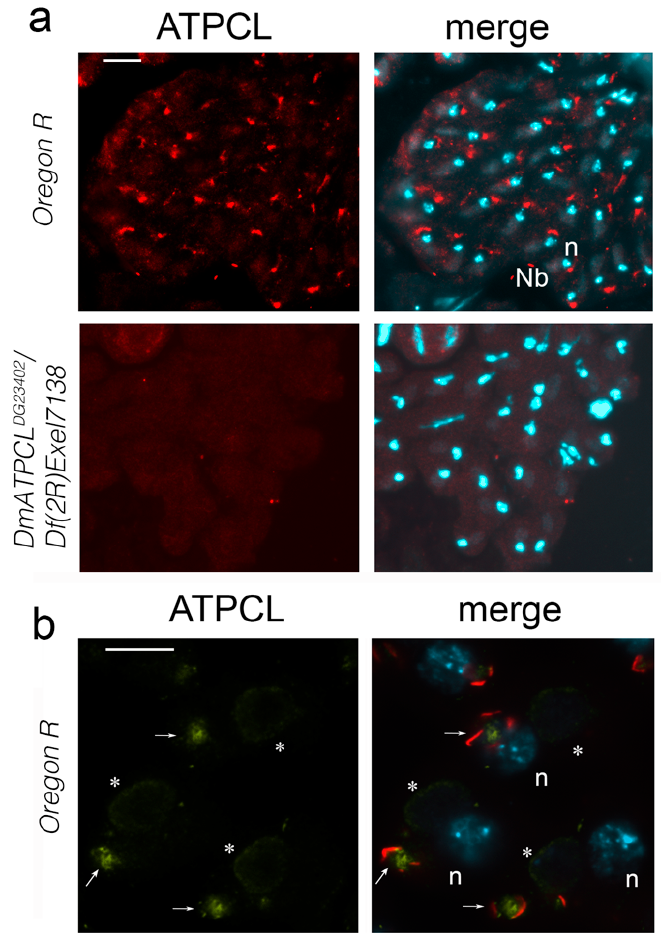
Figure 1. ATPCL localizes at the acroblast. ( a ) Partial cysts of spermatids from wild-type ( Oregon R ) and DmATPCL DG23402 /Df(2R)Exel7138 hemizygous mutants stained for ATPCL (red) and DAPI (blue). Note a juxtanuclear localization of ATPCL that is missing in the mutant spermatids. Localization of ATPCL in the nebenkern (Nb) is unspecific. Scale bar = 10 µm; ( b ) Wild-type onion stage spermatids stained for ATPCL (green in the merge), the Golgi marker Lava Lamp (LAVA, red) and DAPI (blue) showing that ATPCL colocalizes with LAVA in the acroblasts (arrows). Nb = Nebenkern; n = haploid spermatid nuclei; * = unspecific staining on nebenkern. Scale bar = 5 µm.